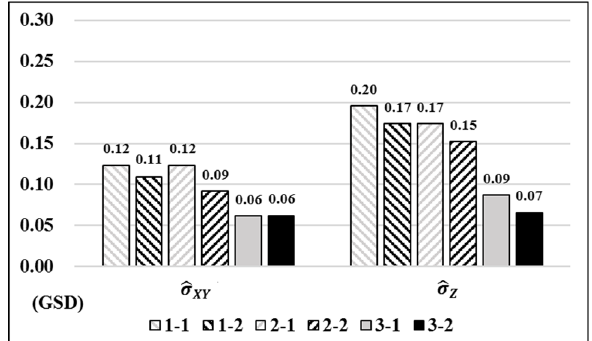
Figure 10. The RMS of (cid:2026)(cid:3548) (cid:3025)(cid:3026) , (cid:2026)(cid:3548) (cid:3027) of all GCPs